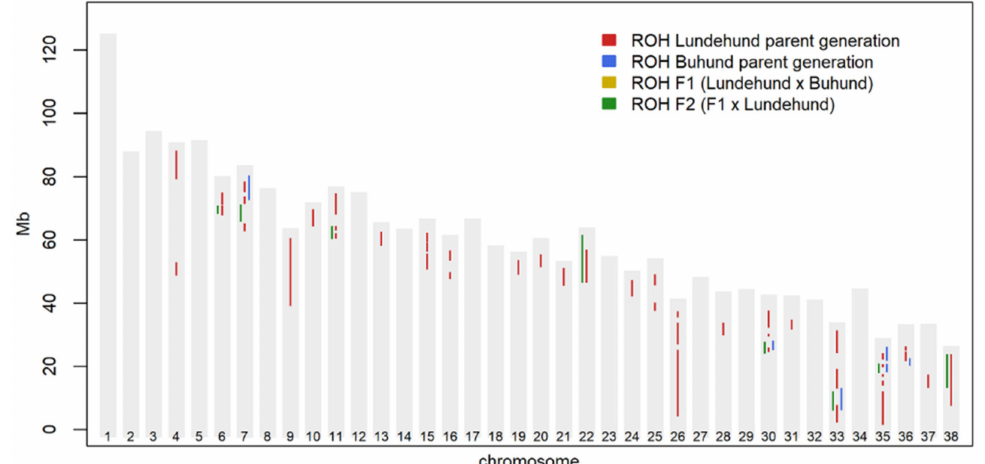
Figure 3. Plots of runs of homozygosity (ROHs) per breed and per chromosome, showing ROHs shared by two or more individuals and based on 34K SNP loci. ROHs were relatively frequent in the Lundehund, and some were also detected in the Buhund, whereas none were observed in the F1 generation. Although we did not sample all the Lundehund individuals involved in the rescue project, the results show that the process has provided, at least temporarily, an increase in genetic